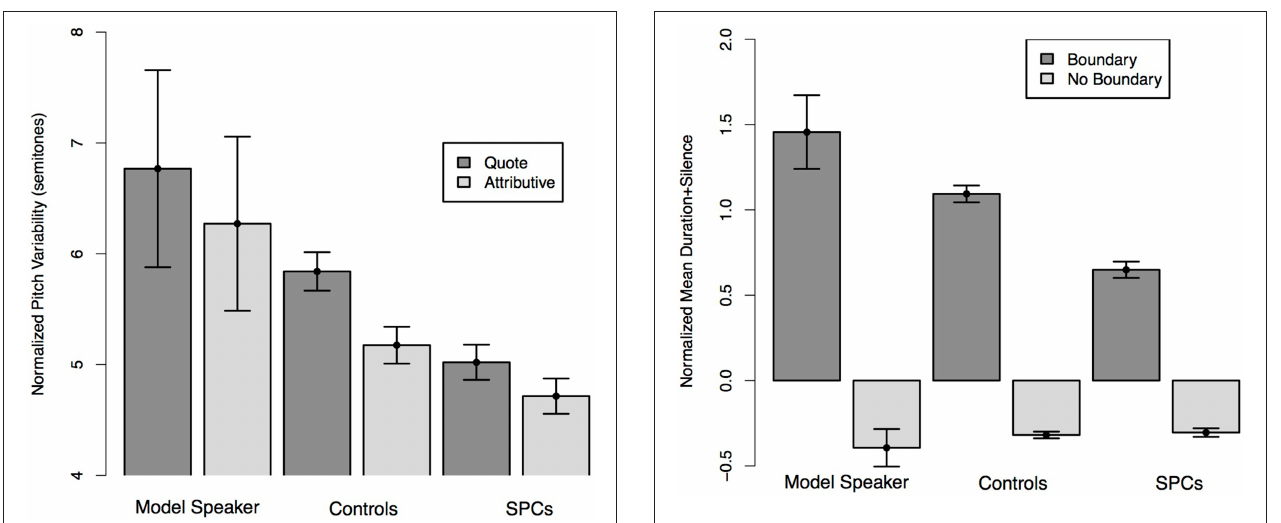
FIGURE 3 | Normalized pitch variability on the quote and attributive phrases of Simple Quotative sentences as produced by the Model Speaker, Control Speakers, and SPCs. Error bars represent standard errors.